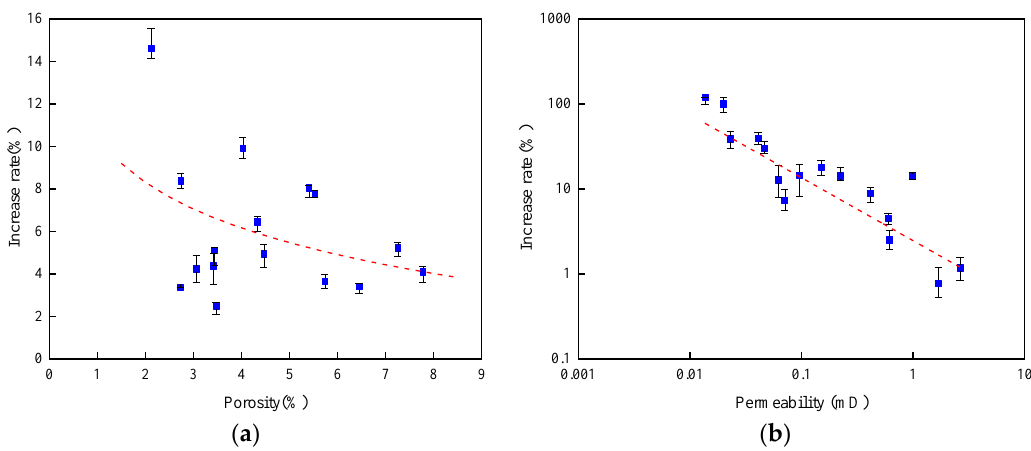
Figure 9. Influence of SB on reservoir parameters: ( a ) porosity; ( b ) permeability.